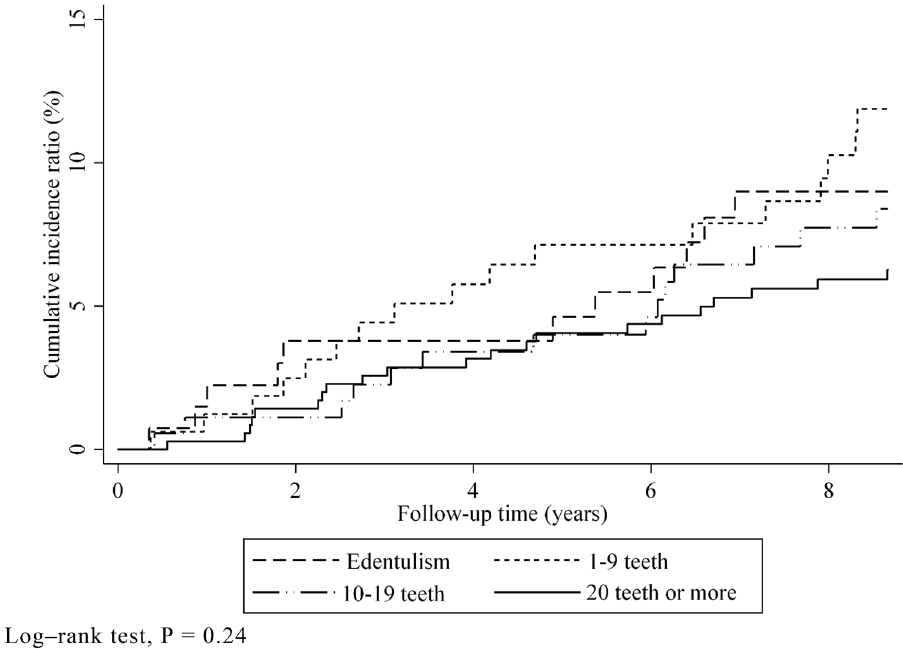
Figure 1. Kaplan–Meier survival curves for the cumulative incidence of gastrointestinal cancer based on the number of remaining teeth (log-rank test, P = 0.24).